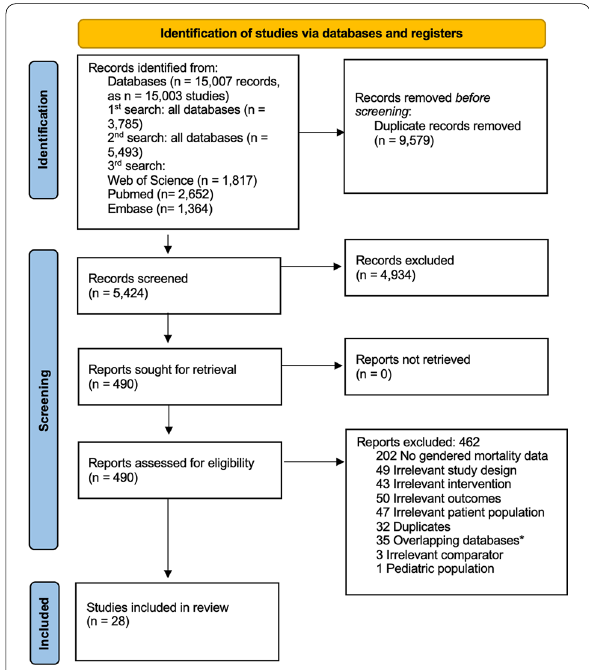
Fig. 1 Flow chart of the included studies. *A table summarizing the overlapping databases is provided in the Additional file 2: Table